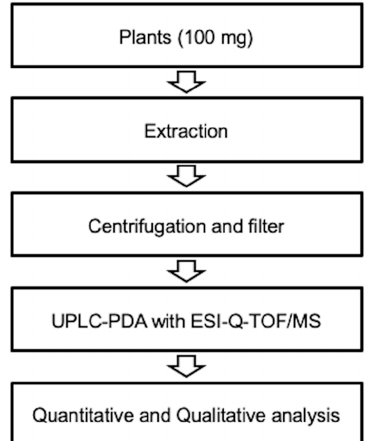
Figure 1. Schematic flowchart showing steps for analysis of 17 phenolic compounds in Amaranthus by ultraperformance liquid chromatography coupled with photodiode-array detector and electrospray ionization quadrupole time-of-flight mass spectrometry (UPLC-PDA/ESI-Q-TOF/MS).